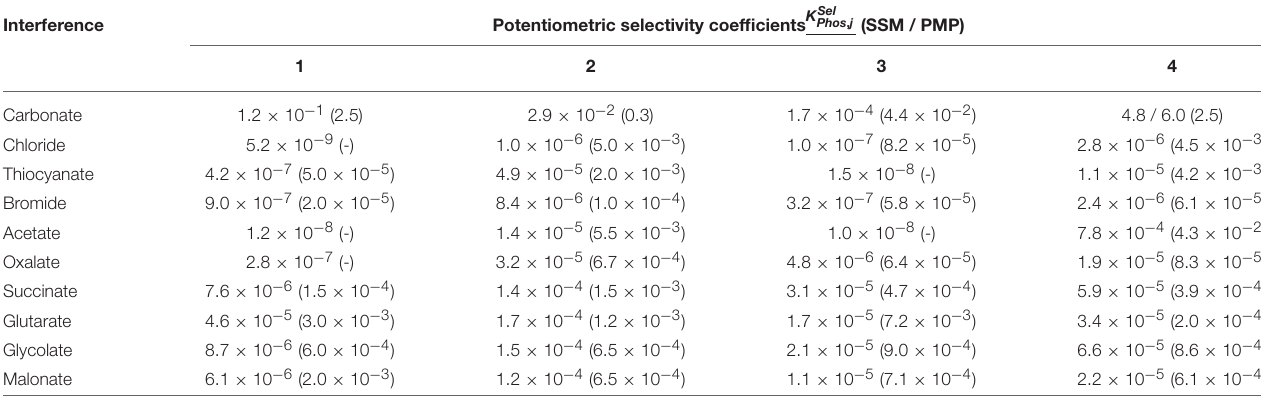
Sel Phos , j of solid-contact potentiometric sensors based on MWCNTs and ILs 1 - 4 calculated by SSM and MPM methods. TABLE 4 | Potentiometric selectivity coefficients K